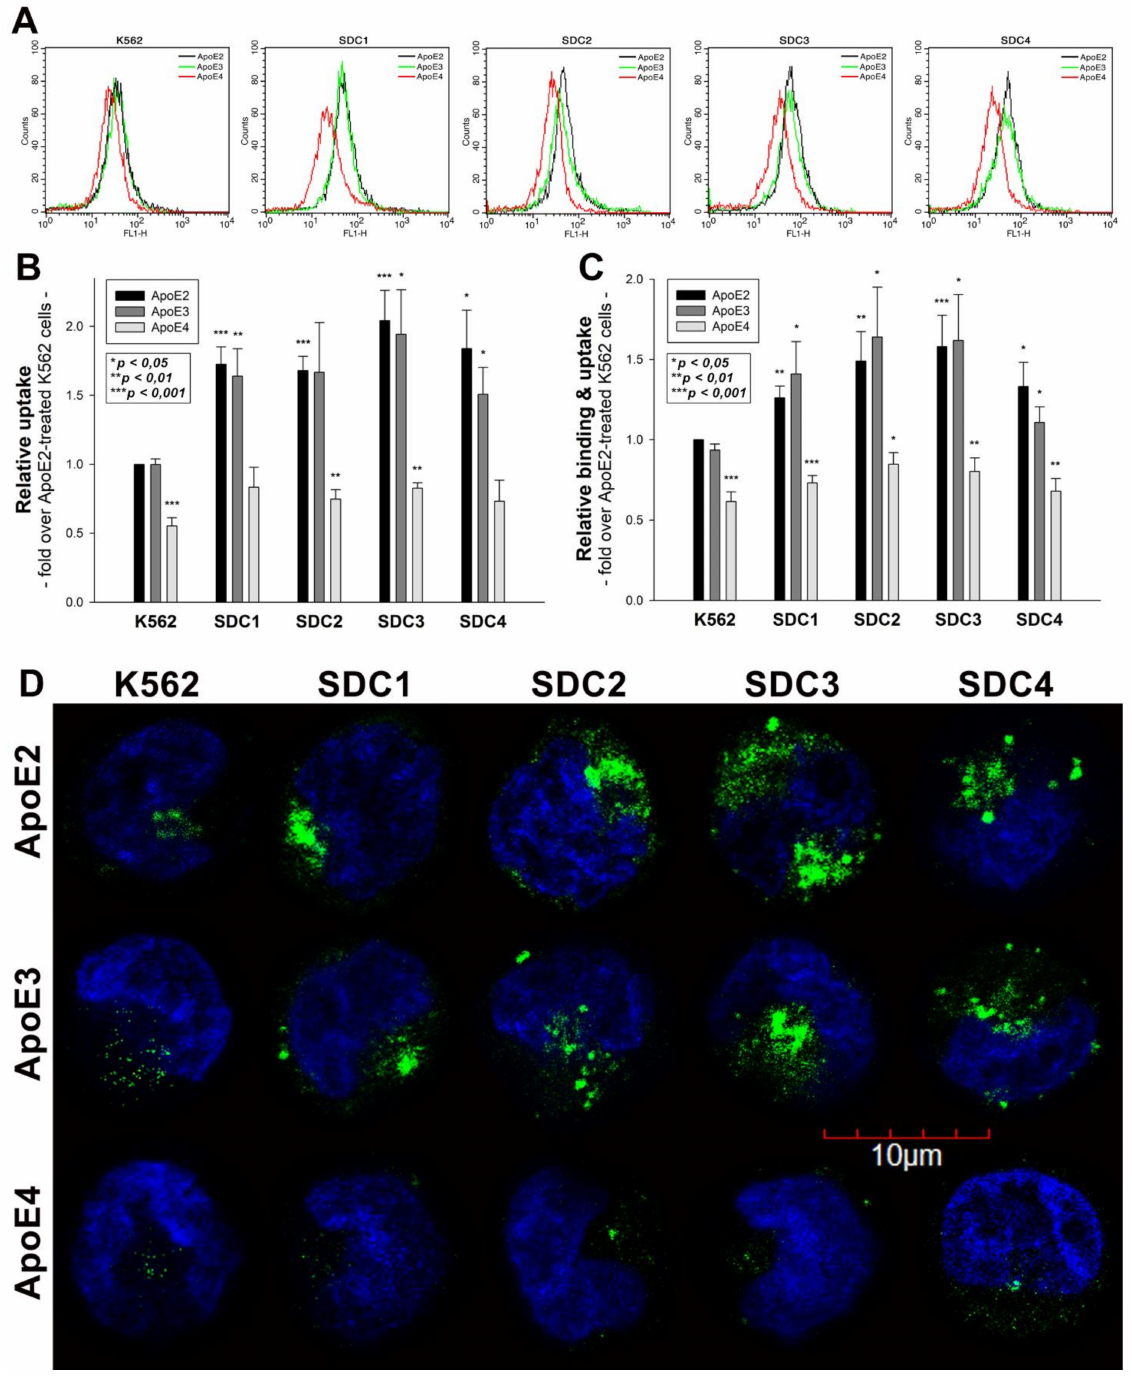
Figure 1. Cellular uptake of ApoEs into WT K562 cells and SDC transfectants. WT K562 cells and SDC transfectants were treated with either of the FITC-labeled ApoE isoforms for 3 h at 37 ◦ C. Cellular uptake of ApoE isoforms was then measured with flow cytometry and confocal microscopy. ( A ) Flow cytometry histograms representing intracellular fluorescence WT K562 cells and SDC transfectants treated with FITC-labeled ApoEs. ( B , C ) Detected intracellular and cellular fluorescence intensities were normalized to FITC-ApoE2-treated WT K562 cells as standards. The bars represent the mean ± SEM of six independent experiments. Statistical significance vs. standards (i.e., FITC-ApoE2-treated WT K562 cells) was assessed with analysis of variance (ANOVA). * p < 0.05; ** p < 0.01; *** p < 0.001. ( D ) Confocal microscopic visualization of ApoE uptake into K562 cells and SDC transfectants. The nuclei of cells were stained with DAPI. Representative images of three independent experiments are shown. Scale bar = 10 µ